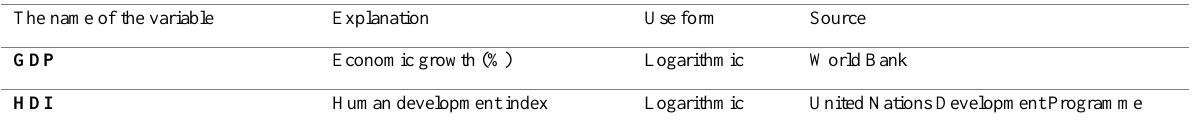
Table 6: Data Used in the Study